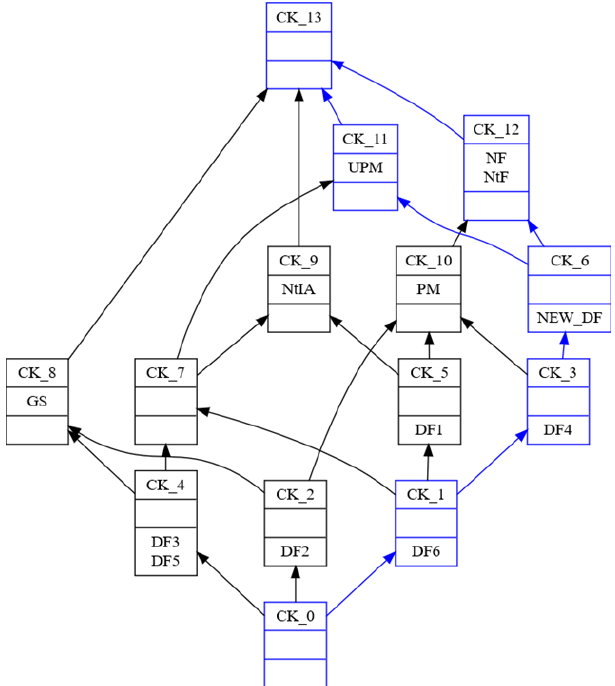
Figure 6. The simplified version of 𝐿 𝐾 updated with a new dairy farm NEW_DF .